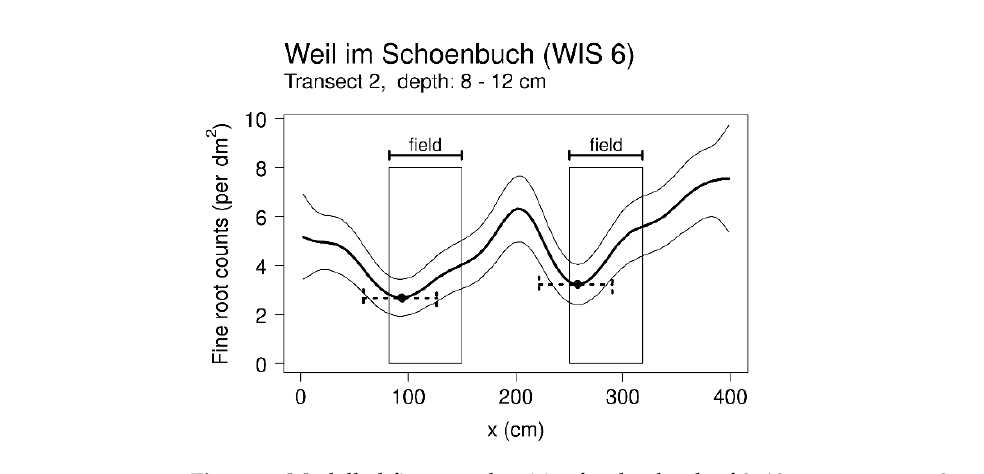
Figure 2. Modelled fine root densities for the depth of 8–12 cm at transect 2 at (WIS 1). Mean root density (bold line) is shown together with the confidence interval ( ± twofold standard deviations; narrow lines). The transparent-filled bar represents the field classification of the wheel track location. The filled dots show the two minima of fine rooting for this depth layer, which was used as a centre location for the reallocation of the horizontal spreading (dotted line).